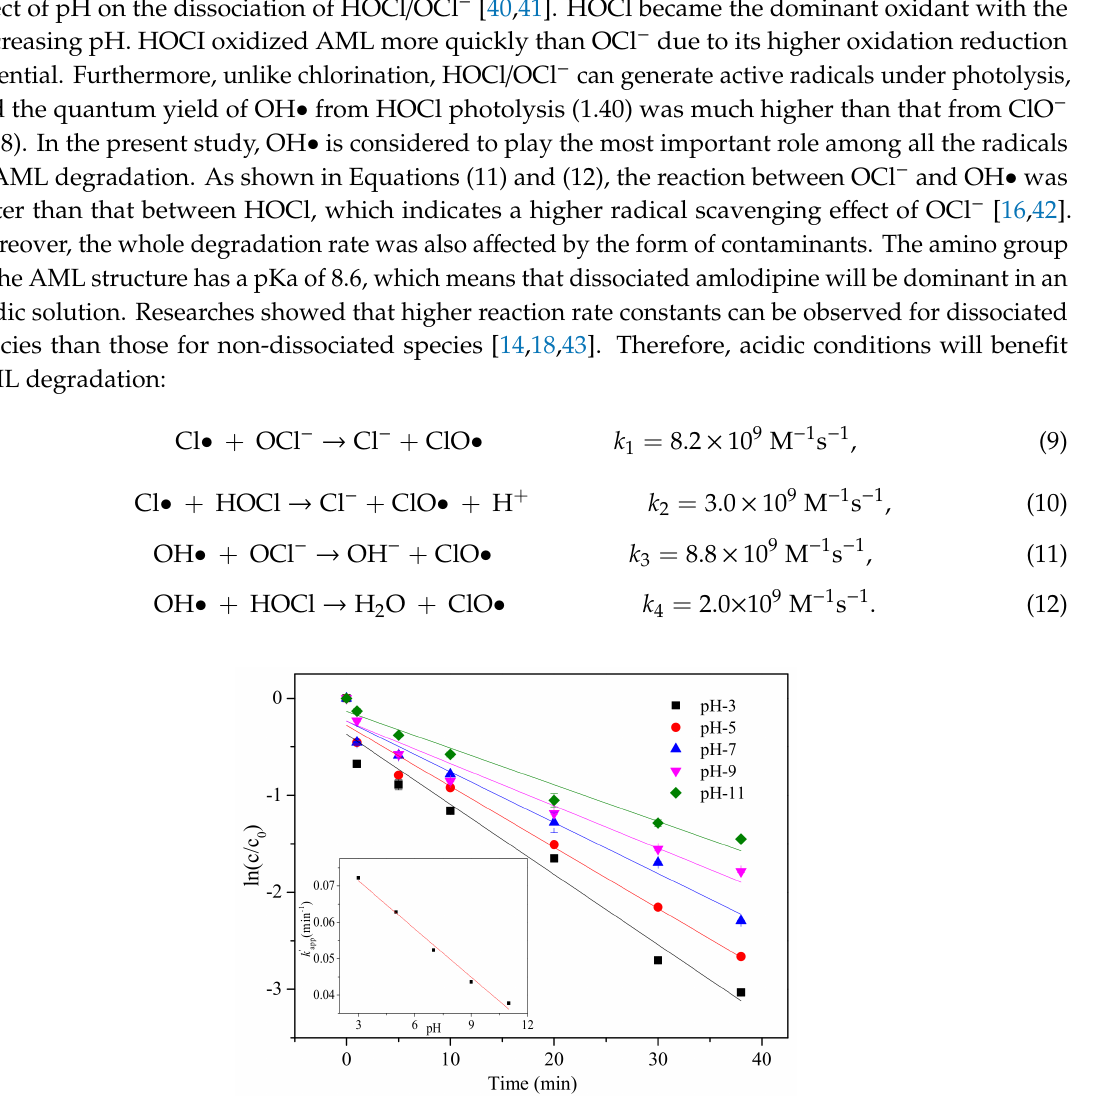
Figure 4. E ff ect of the pH value on AML degradation by the UV / chlorine process ([AML] 0 = 10 µ M, [chlorine] 0 = 30 µ M, UV intensity = 500 µ W · cm − 2